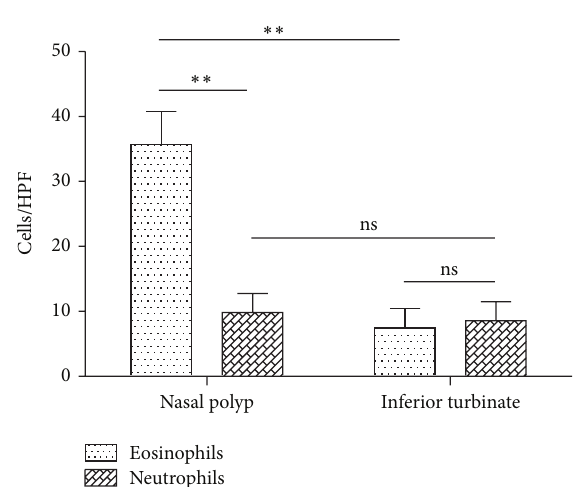
Figure 5: Eosinophils and neutrophils counts in nasal polyps and inferior turbinates ( 𝑛 = 8 ). Eosinophil counts were significantly higher in nasal polyps compared to inferior turbinates ( 𝑃 = 0.007 ). Neutrophil counts did not significantly differ between nasal polyps and inferior turbinates. Noticeable is that there was a significant difference between eosinophil and neutrophil counts in nasal polyps ( 𝑃 = 0.0014 ) and balanced counts in inferior